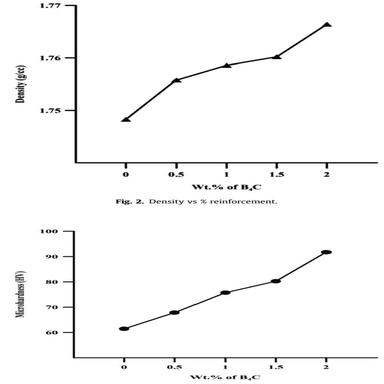
Hardness Vs wt.% of Reinforcement.